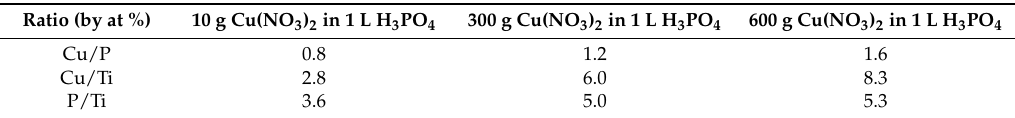
Table 6. Cu/P, Cu/Ti and P/Ti ratios gained on the basis of XPS results. Ratio (by at